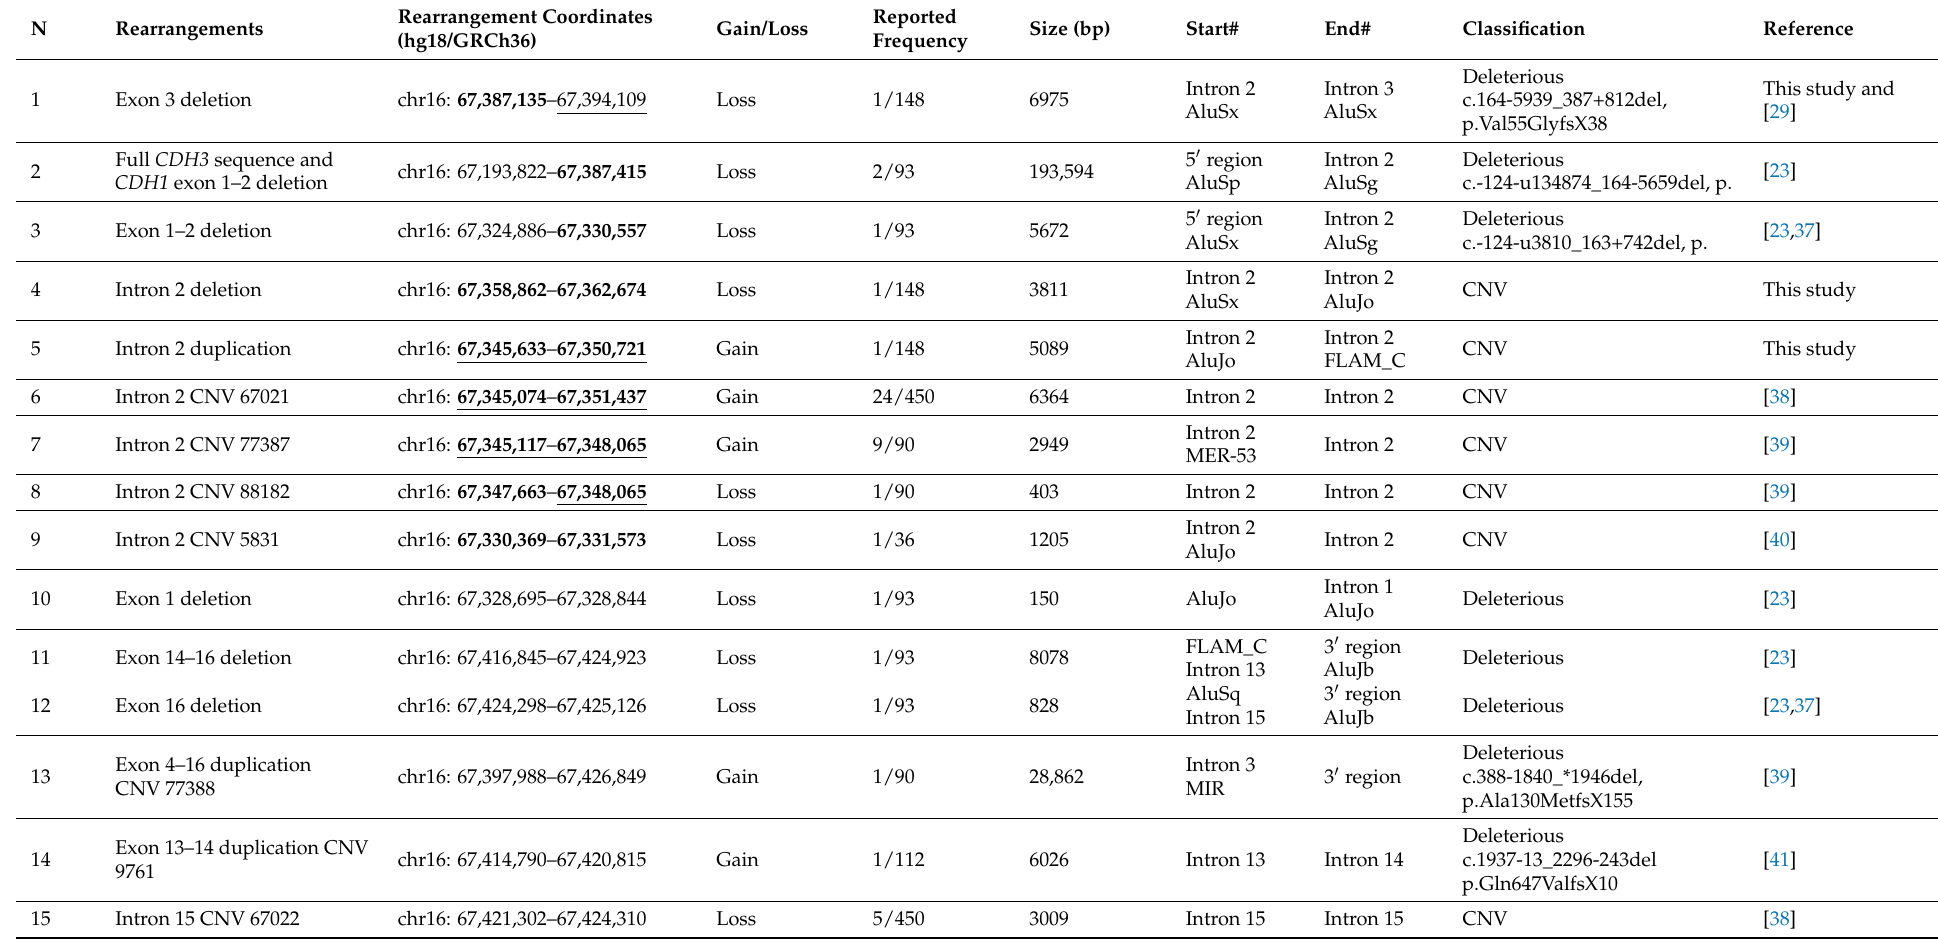
Table 2. Summary of the CDH1 rearrangements and CNVs reported in this study and in the literature. In bold, the breakpoint in intron 2 of CDH1 gene and underlined are common regions found in at least two rearrangements. In the start and end column are reported the nature of the boundary and the presence of repeated